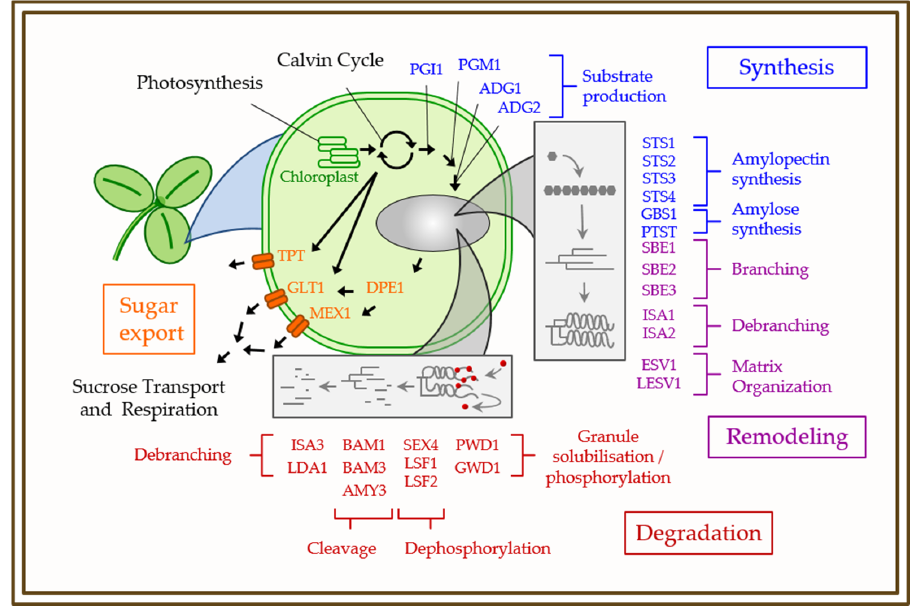
Figure 2. The synthesis and degradation of the complex semi-crystalline structure of starch is orchestrated by a series of enzymes that are involved in four basic processes. Synthesis: fructose-6-P from the Calvin cycle is isomerized (PGI1; PGM2) before it is activated with a UDP moiety (ADG1; ADG2). Soluble and granule bound starch synthases polymerize UDP-Glucose to produce amylose and amylopectin (STS1-4; GBS). Remodeling: the crystalline helical structure of starch requires the amylopectin to be remodeled, which is carried out by branching enzymes (SBE1-3) and debranching isoamylase (ISA1-2). Degradation: To release the soluble sugars from the starch granule, first the amorphization of the crystalline structure must be carried through glucan phosphorylation, which is done by glucan dikinases (GWD1; PWD1). Once amorphous, phosphatases remove the phosphate from the glucan chain (SEX4, LSF1-2), allowing hydrolyzing enzymes such as the β -amylases, (BAM1-3), α -amylases (AMY3), isoamylase (ISA3), and limit dextranase (LDA1) to cleave the glucan polymer. Export: Prior to export, oligomaltosaccharides are disproportioned to glucose and maltose (DPE1). These soluble sugars are exported out of the chloroplast by the maltose exporter (MEX1) and glucose transporter (GLT1). Enzyme nomenclature is based on arabidopsis for the enzymes that are conserved in higher plants.